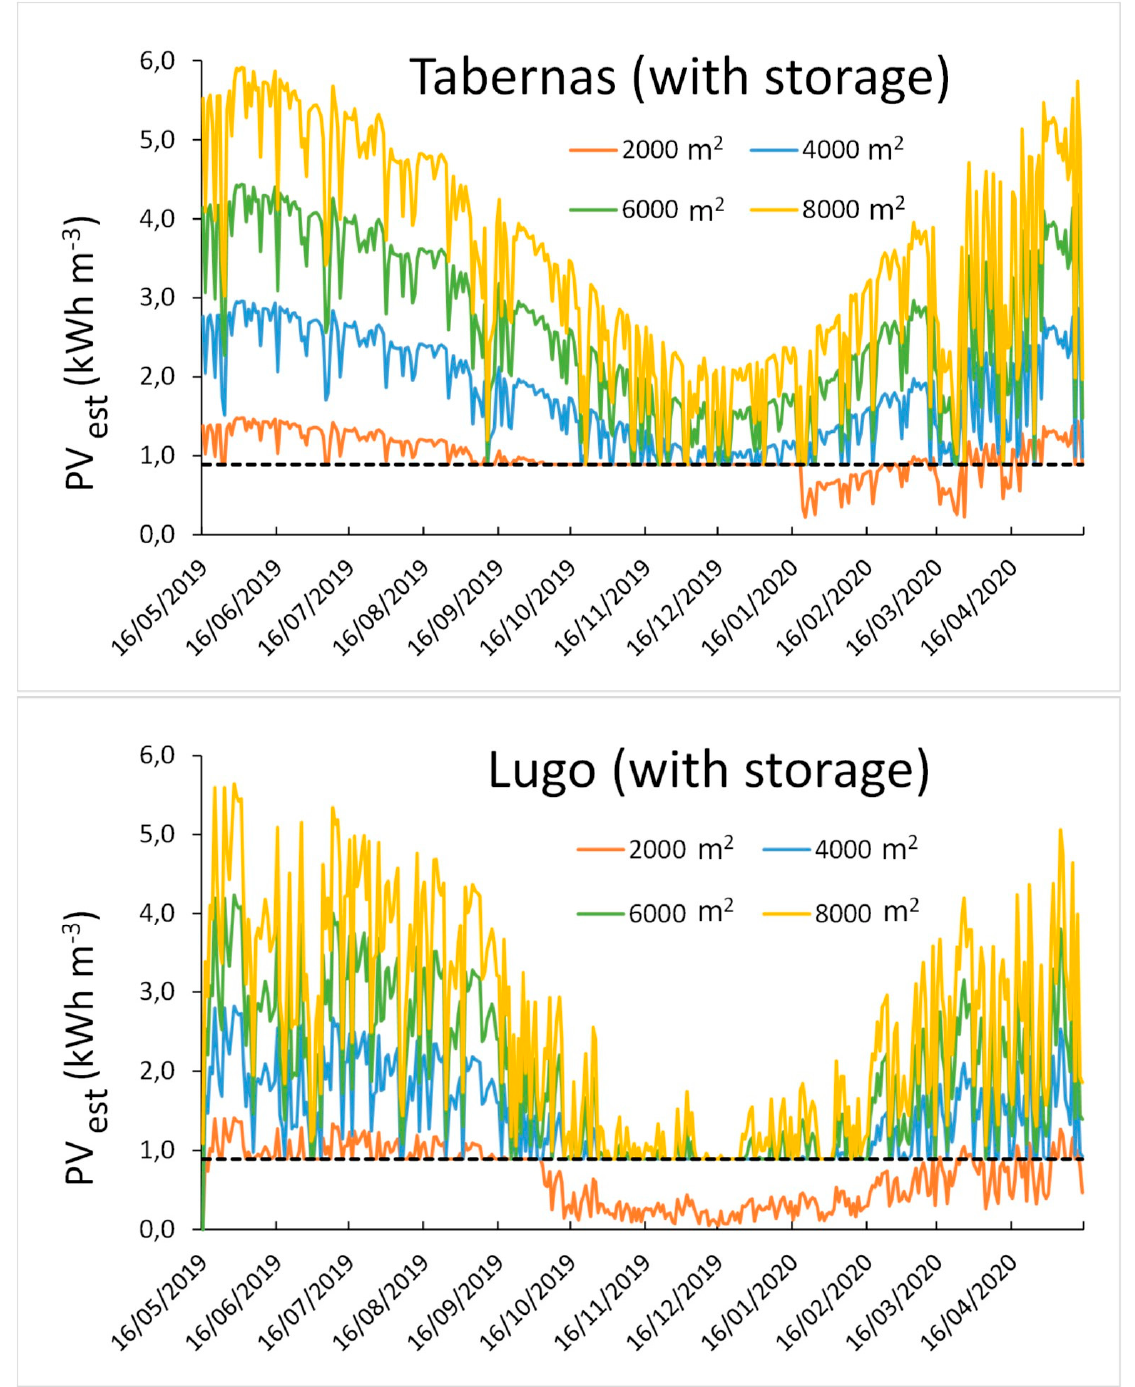
Figure 5. PV power for different areas considering storage; the energy consumption threshold is included (0.89 kWh m − 3 ).